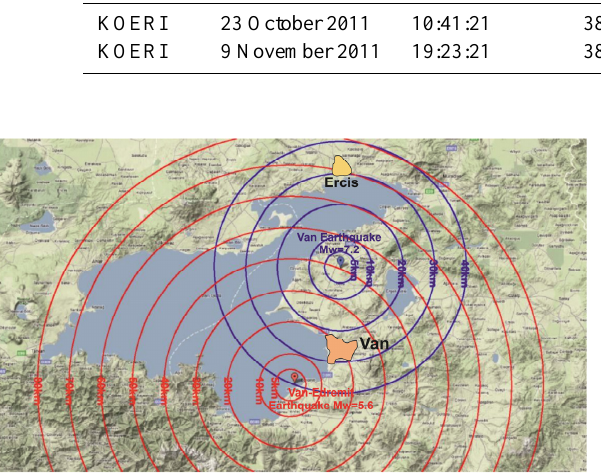
Fig. 1. Van and Van-Edremit earthquakes distance to epicenter (Önen et al., 2011). Fig. 1. Van and Van–Edremit earthquakes distance to epicenter ( ¨Onen et al.,